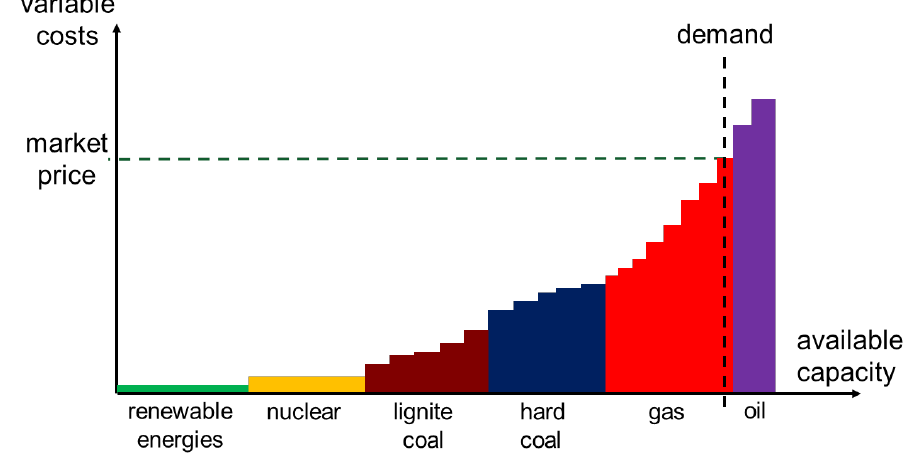
Figure 3. Variable costs of power production [14].